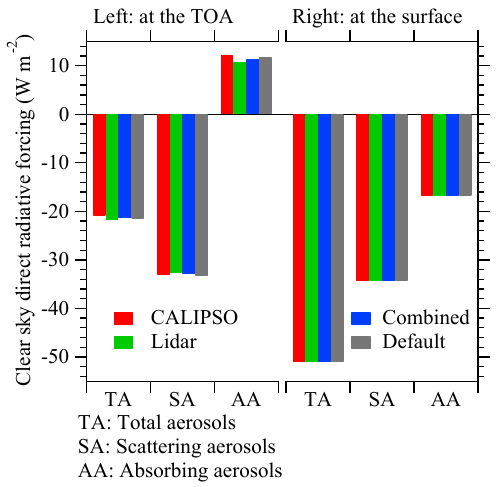
Figure 14. Sensitivities of the TOA and the surface aerosol DRFs (daytime, Wm − 2 ) to the different aerosol profiles in clear condi- tions, for the total, scattering and absorbing